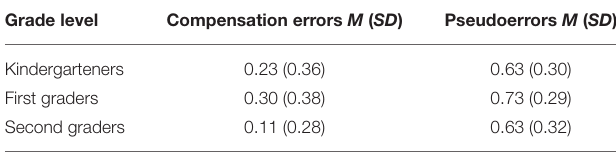
TABLE 5 | Percentages of justifications of children in the detection task. TABLE 6 | Means and SD of bias scores.